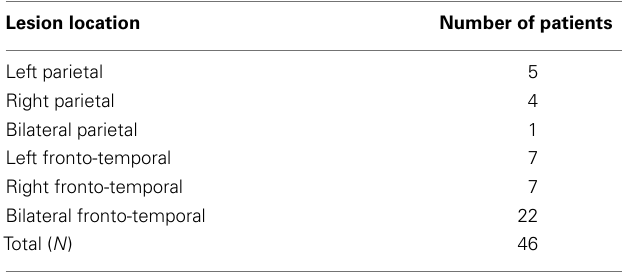
Table 2 | Lesion location for study participants